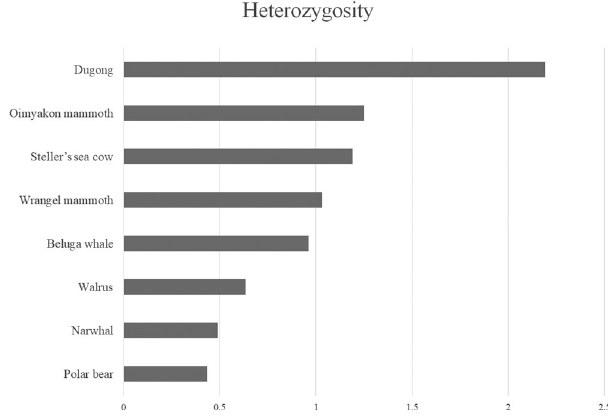
Fig. 2 Average genome-wide autosomal heterozygosity values of Steller ’ s sea cow and modern marine mammalian genomes. The X -axis represents the average proportion of sites within the autosomes that are heterozygous. The Y -axis represents mammalian